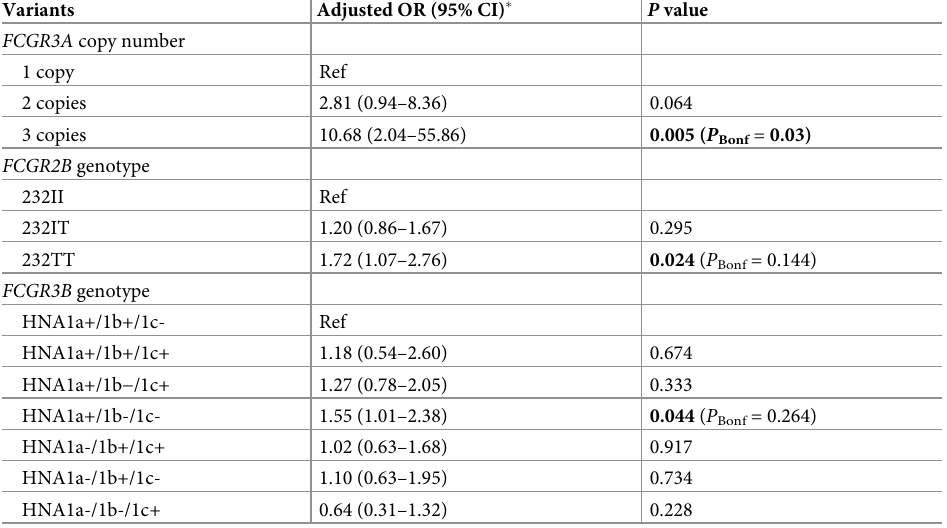
OR, Odds Ratio; CI, Confidence Interval; P Bonf , Bonferroni corrected P value. Bold indicates statistical significance of P < 0.05. � Multivariate model controlled for FCGR3A copy number, FCGR2B and FCGR3B